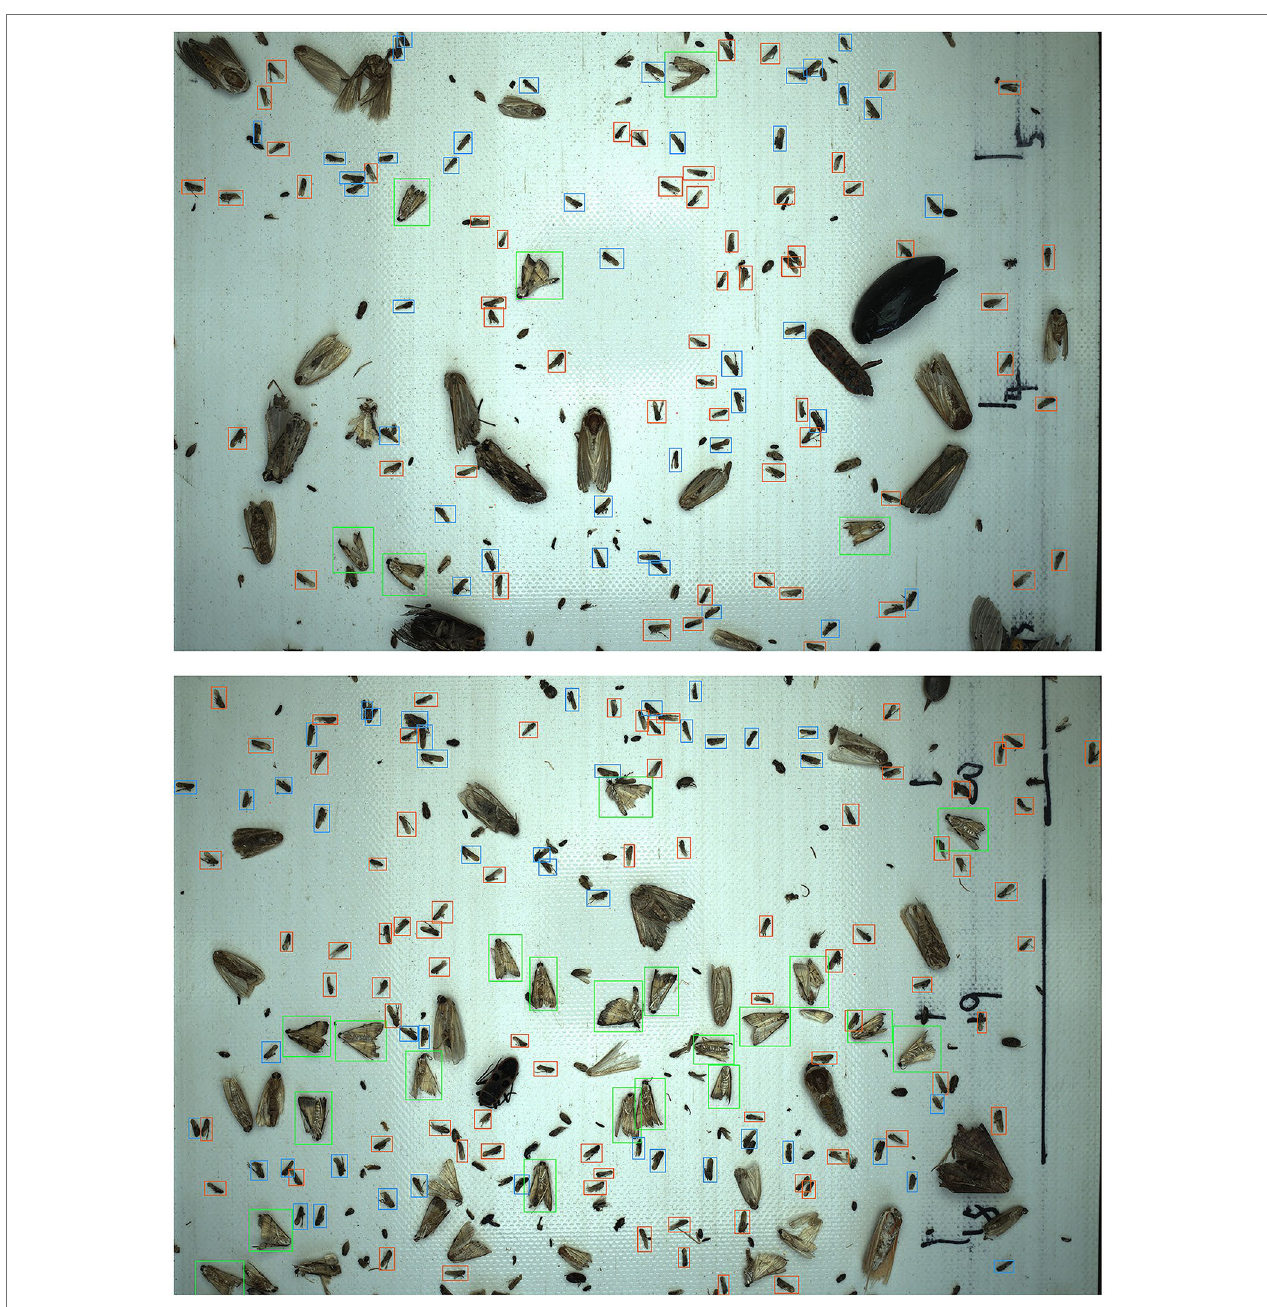
FIGURE 6 | Examples of detected pests. The green, orange, and blue boxes contain C. medinalis , S. furcifera , and N. lugens ,